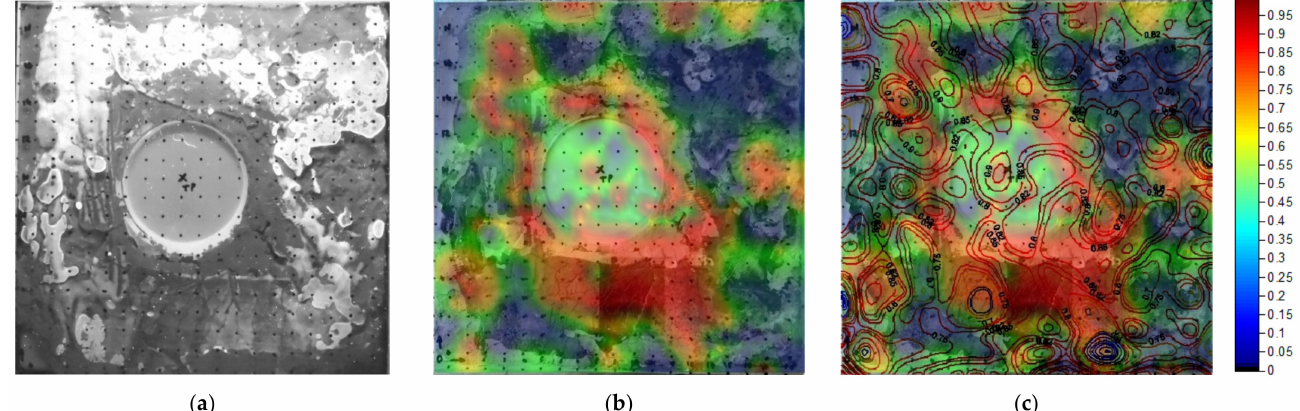
Figure 9. Photograph of the test object made in the laboratory ( a ): a 4.8 mm thick PMMA slab, glued to a tile used as a base, the center of which was kept free to form an evident hole and a cement mortar with non-uniform thickness was used in the surrounding part. The impact-test measurement carried out was reported in ( b ), while in ( c ) is a fusion with audio cross-correlation measure (using the contour lines